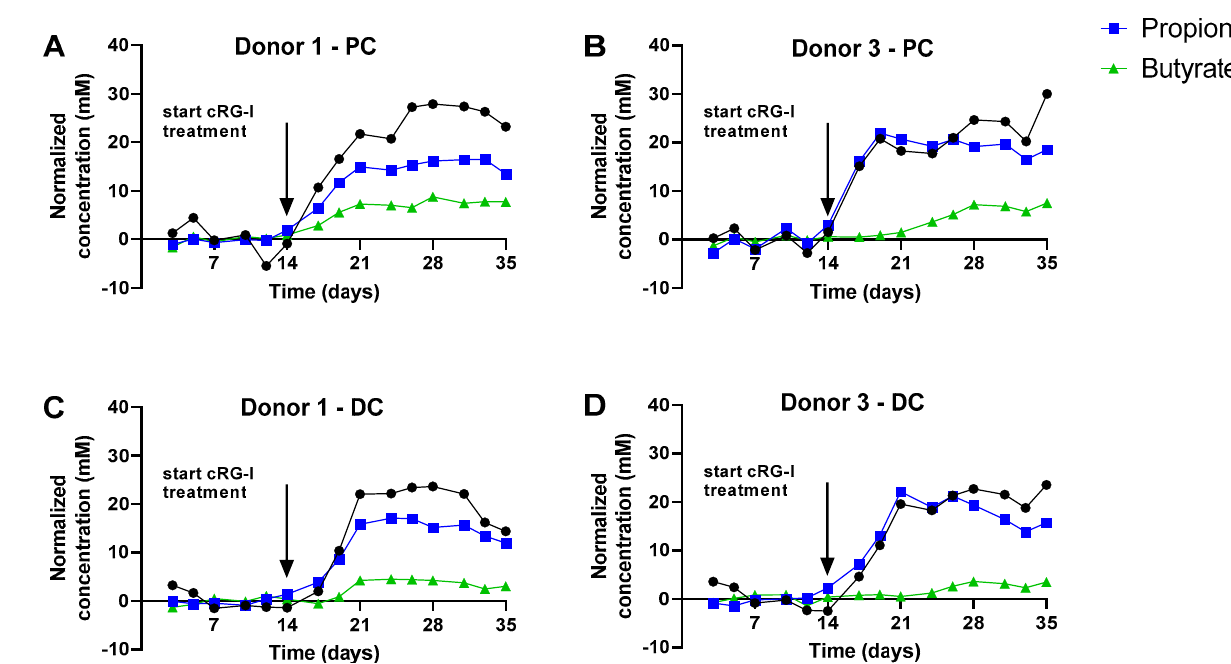
Figure 3. Effect of fermentation of cRG-I on SCFA production in the simulated proximal and distal colon during both the control (Days 0–14) and treatment period (Days 14–35) of the quad-M-SHIME for Donors 1 (panels A and C ) and 3 (panels B and D ). Data are expressed as normalized values versus the average of the control period. Donor A and C results are representative of those obtained for Donors B and D, respectively (see Supplementary Figure S1). Arrows indicate the start of the cRG-I treatment. cRG-I = carrot-derived Rhamnogalacturonan I, DC = distal colon, PC = proximal colon. The absolute values on which the normalized concentrations are based are shown in Figure S2 panels A/C/E/G.